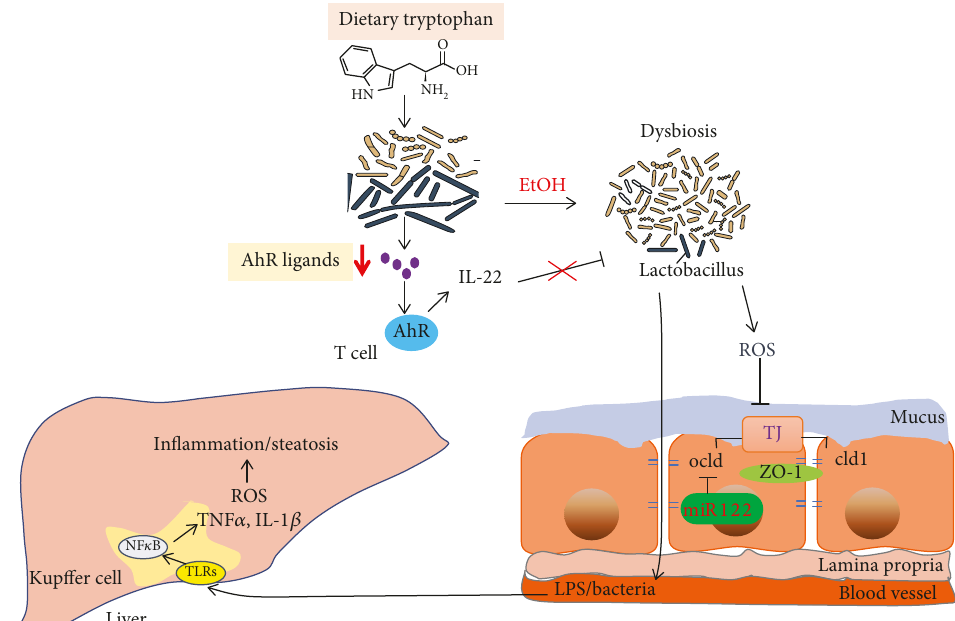
Figure 1: The e ff ect of alcohol on the gut-liver axis. Alcohol signi fi cantly changes intestinal microbiota diversity, reduces intestinal epithelial tight junction protein expression, and increases intestinal mucosal permeability, leading to barrier dysfunction and endotoxin translocated into the blood, inducing in fl ammatory cytokine and ROS production in the intestine and liver, causing hepatic steatosis and in fl ammation. Alcohol disorders the gut microbiota and decreases AhR ligand and IL-22 production. Alcohol exposure increased intestinal miR122a expression, decreasing occludin